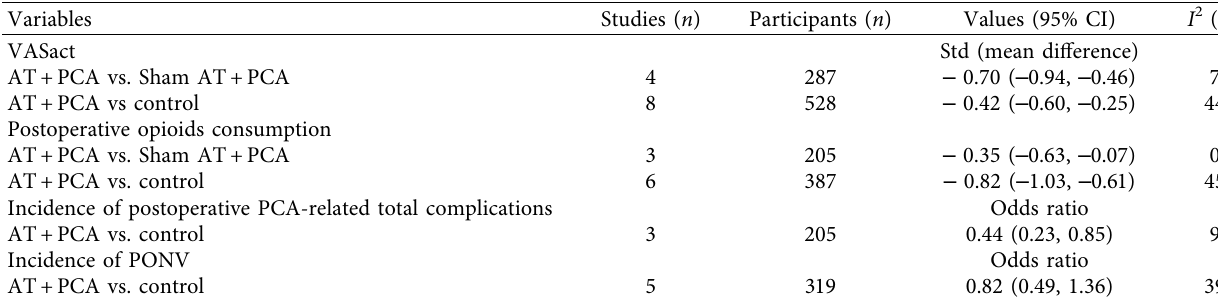
Figure 3: Forest plots of VAS. AT: acupuncture. Table 3: Summary of the